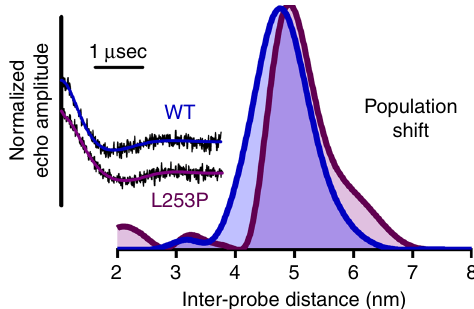
Fig. 3 DEER measurement showing the L253P mutation opens the β -III- spectrin ABD structure. Echo amplitude decays of WT ABD (blue) and L253P ABD (purple) along with their corresponding Tikhonov fi ts are shown on the left. The inter-probe distances derived from Tikhonov regularization (Supplementary Fig. 6) for both WT and L253P ABDs are shown on the right. The WT ABD distance distribution is centered at 4.8 nm, consistent with the distance predicted in the homology model of the closed state shown in Supplementary Fig. 5. Upon introduction of the L253P mutation, the distance distribution undergoes a shift to populate a longer inter-probe distance, visible as a shoulder to the right of the 4.8 nm peak, consistent with structural opening of the